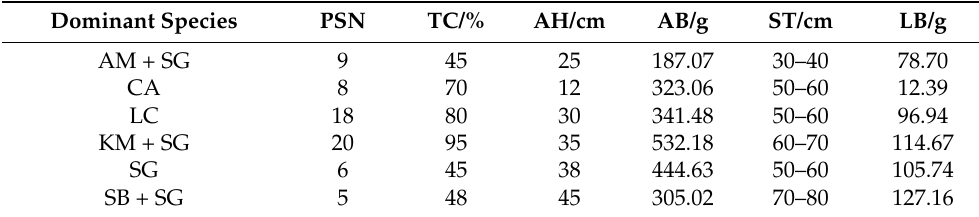
Table 1. Basic situations of the sampling plots.